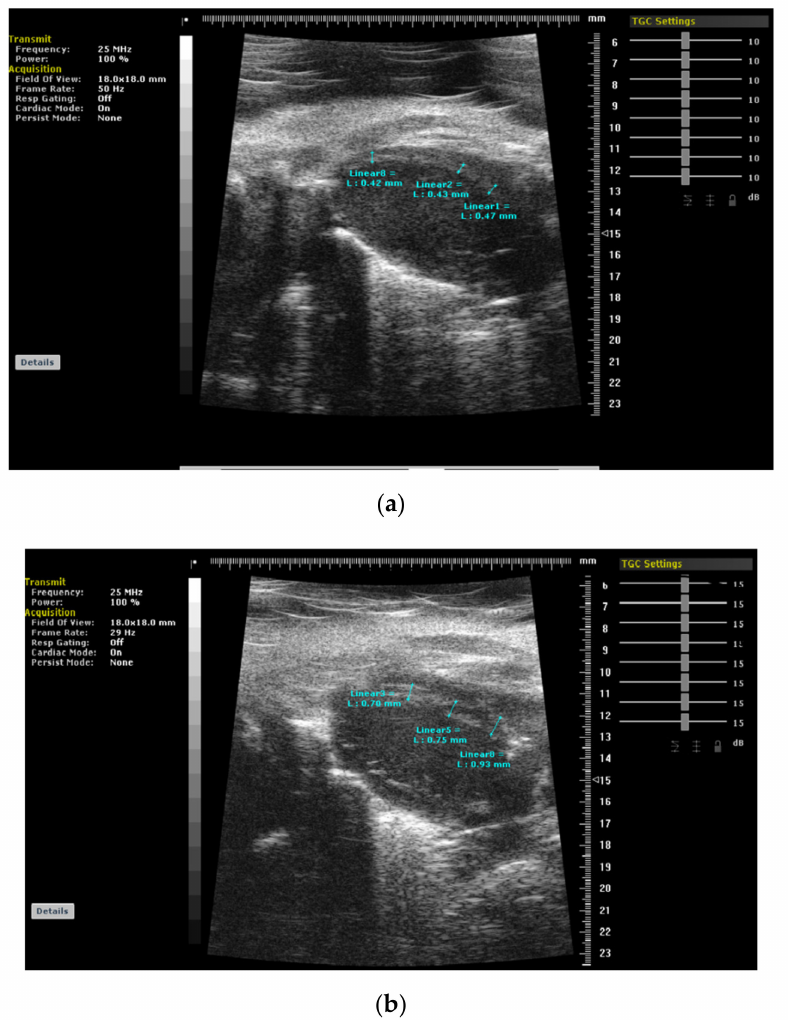
Figure 4. ( a , b ): Cardiac images of a mice using 3rd generation microscopic ultrasound show normal cardiac geometry and a regularly remodeled septal wall with thickerseptal base at 4 weeks after stress induction due to pressure-overload (TAC: transverse aortic construction),